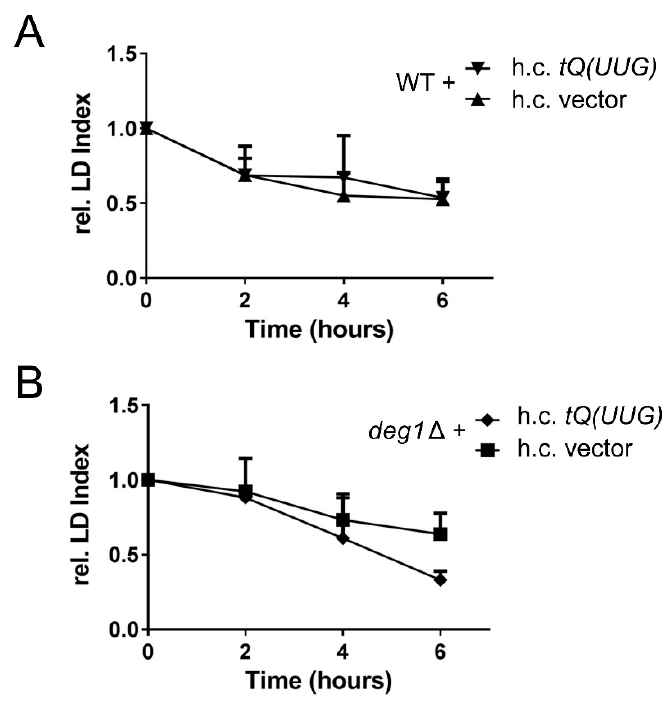
Figure 5. Suppression of lipolysis defects in deg1 mutants by overexpression of tRNA Gln UUG. Wild type (WT) ( A ) and deg1 ∆ ( B ) cells were transformed with empty vector (h.c vector) or tRNA Gln UUG multicopy plasmid (h.c. tQ(UUG) ). Strains were seeded at low density and the lipid droplet dynamics were assayed during exponential phase (6 h) in YPD medium. The mean ± S.D. of three independent experiments is shown.